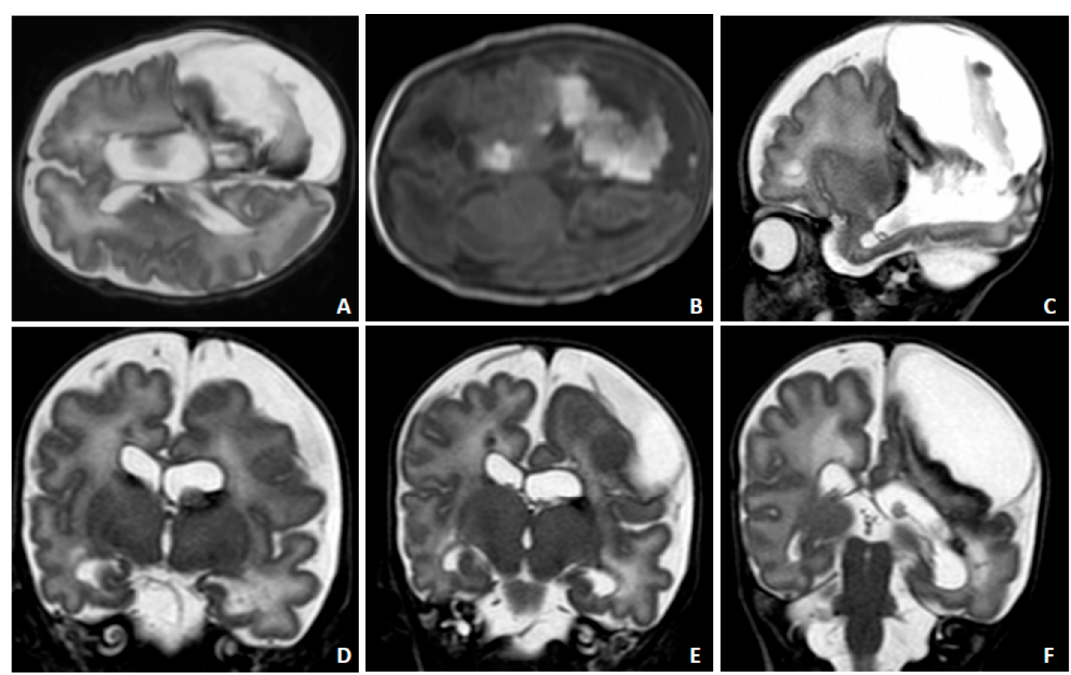
Figure 5. Neonatal MRI for Case 2 after 20 days of postnatal life. Chronic intraparenchymal and extraparenchymal hemorrhagic lesion with cystic appearance in the left cerebral hemisphere, ex vacuo ventricular enlargement ( A – F ) (( A , B ): see paramagnetic component in T2 and T1 W images due to methemoglobin and hemosiderinic residual alterations). Persistent intraventricular septation with temporal horn cyst ( C , E , F ).